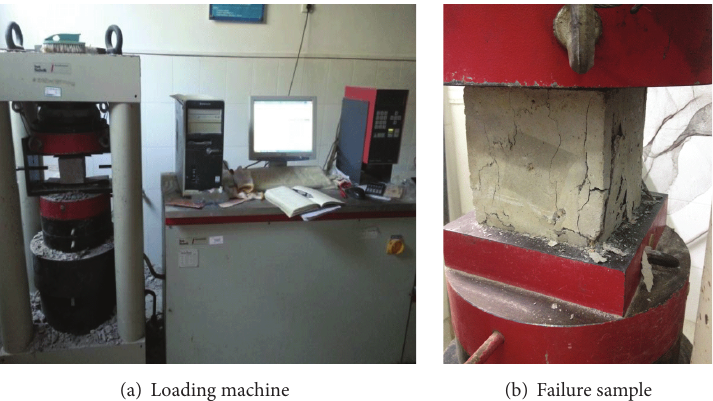
Figure 2: Axial compression test setup of the corroded samples.